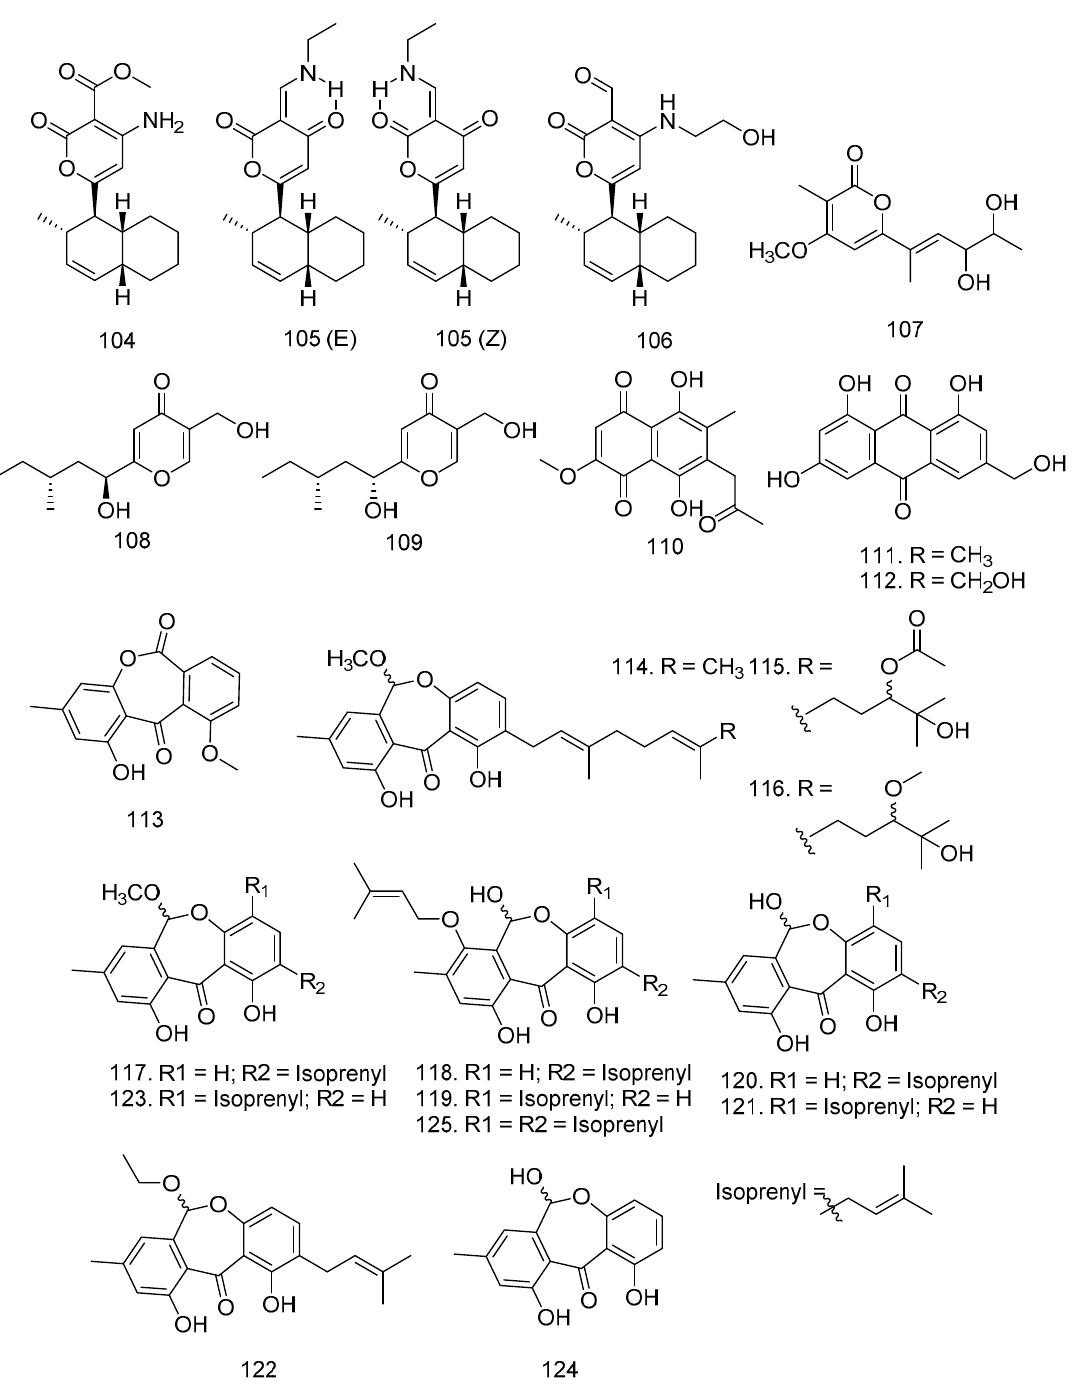
Figure 6. Pyrones ( 104 – 109 ), quinone ( 110 ), and anthraquinones ( 111 – 125 ) were isolated from Meliaceae-derived fungi.